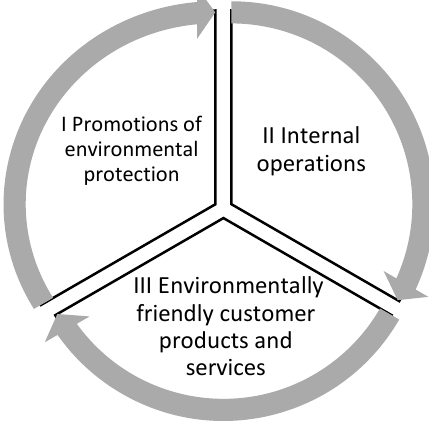
Fig. 1. Environmental operations of